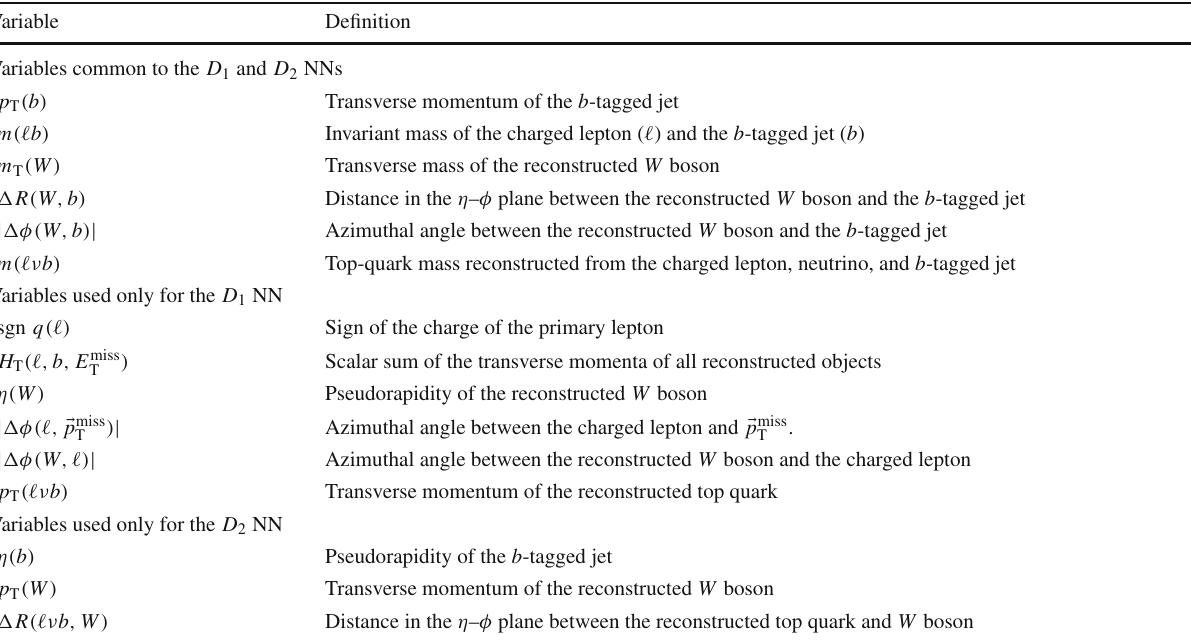
Table 2 Input variables to the two